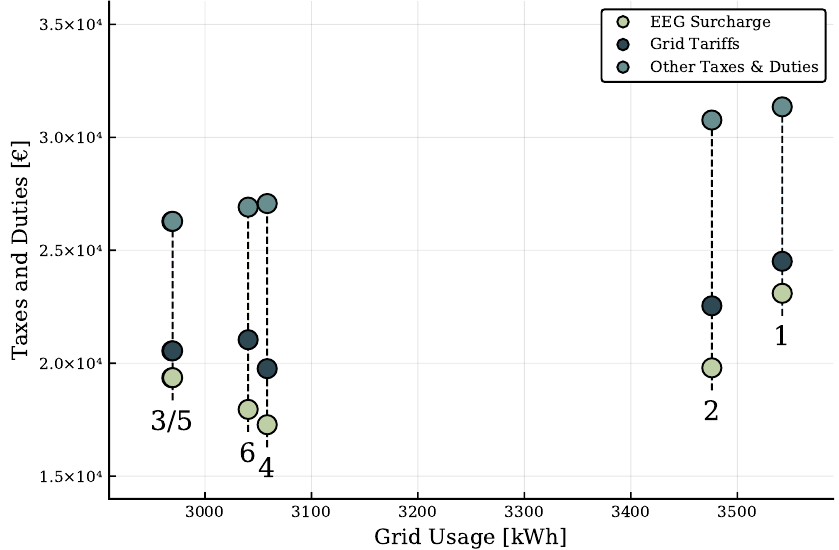
Figure 3. Comparison of taxes and duties for the simulated market